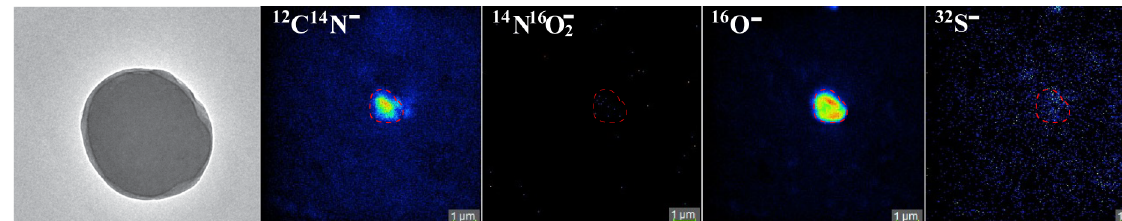
Figure 3. NanoSIMS-based ion intensity mappings of 12 C 14 N − , 14 N 16 O −